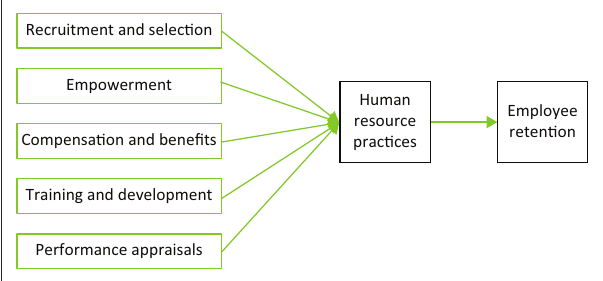
FIGURE 1: Research